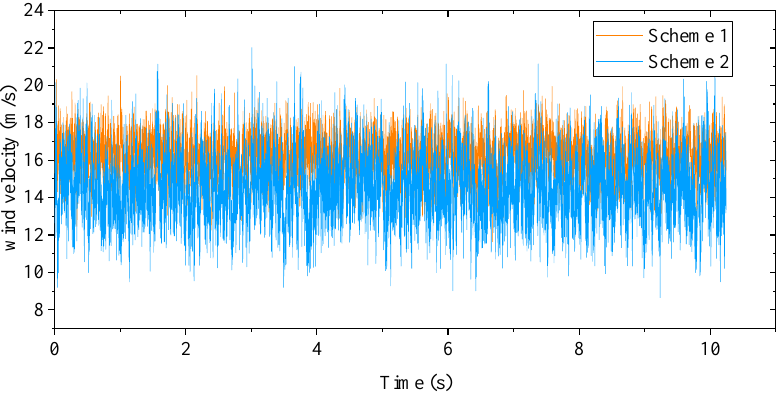
Figure 7. The time series of the instantaneous streamwise velocity (the 6th section, central measuring point).